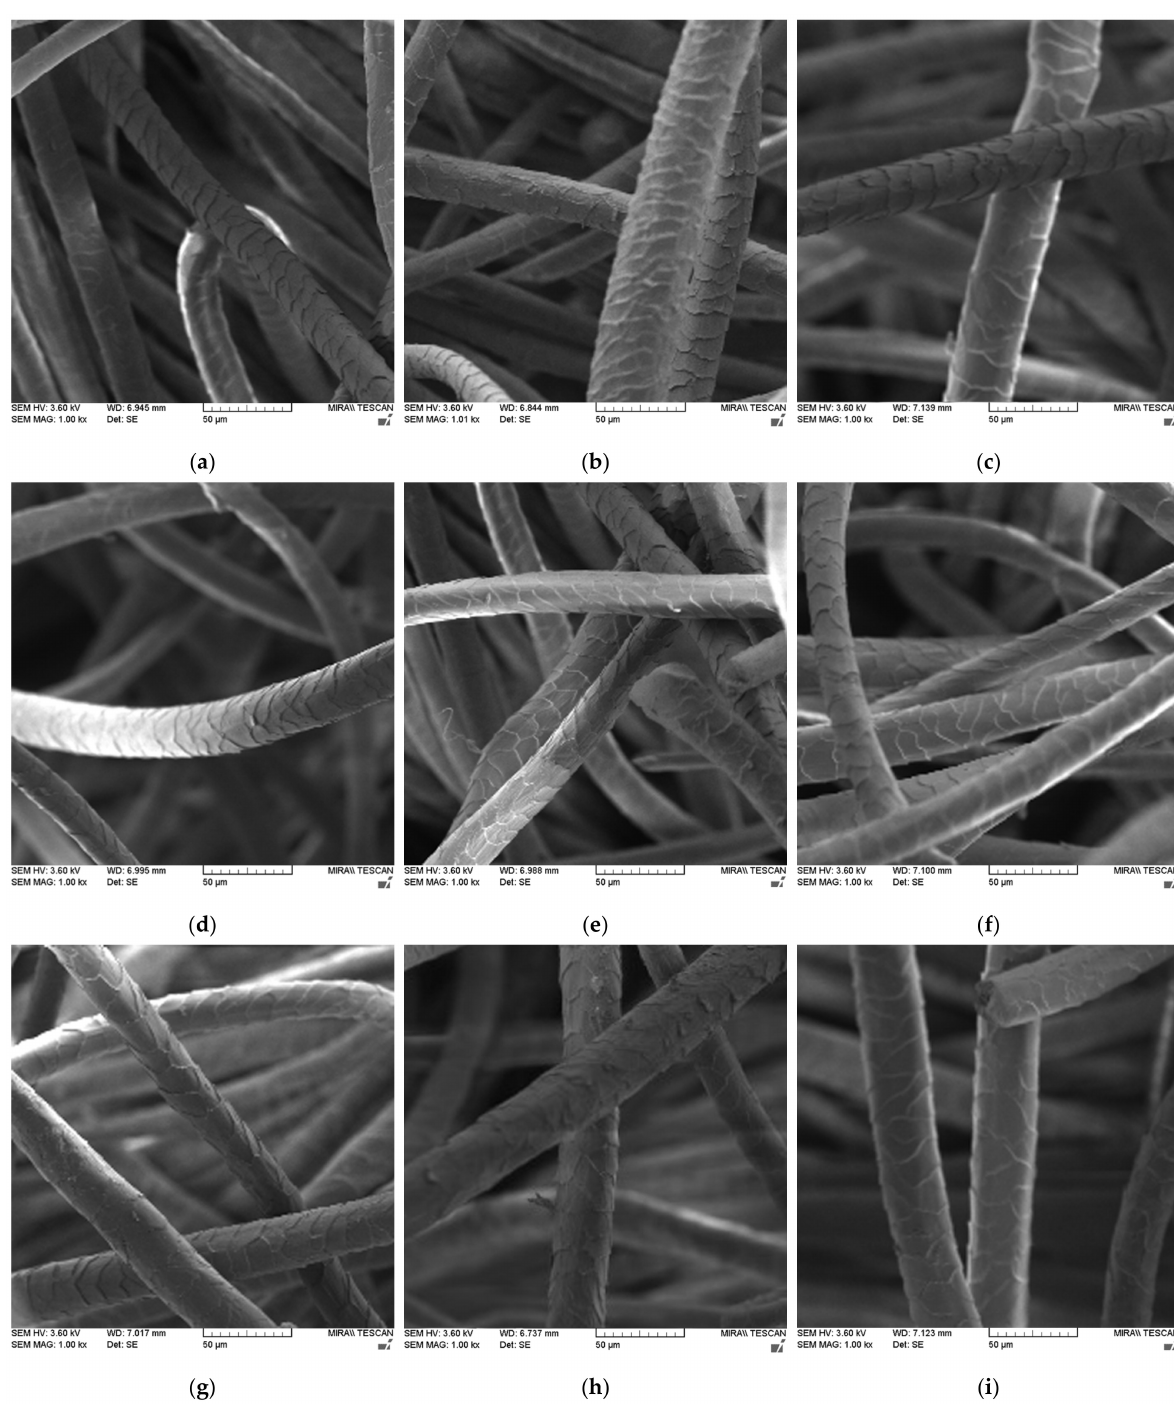
Figure 3. SEM micrographs of scoured and bleached wool. ( a ) CS; ( b ) CS-HP; ( c ) CS-PC; ( d )